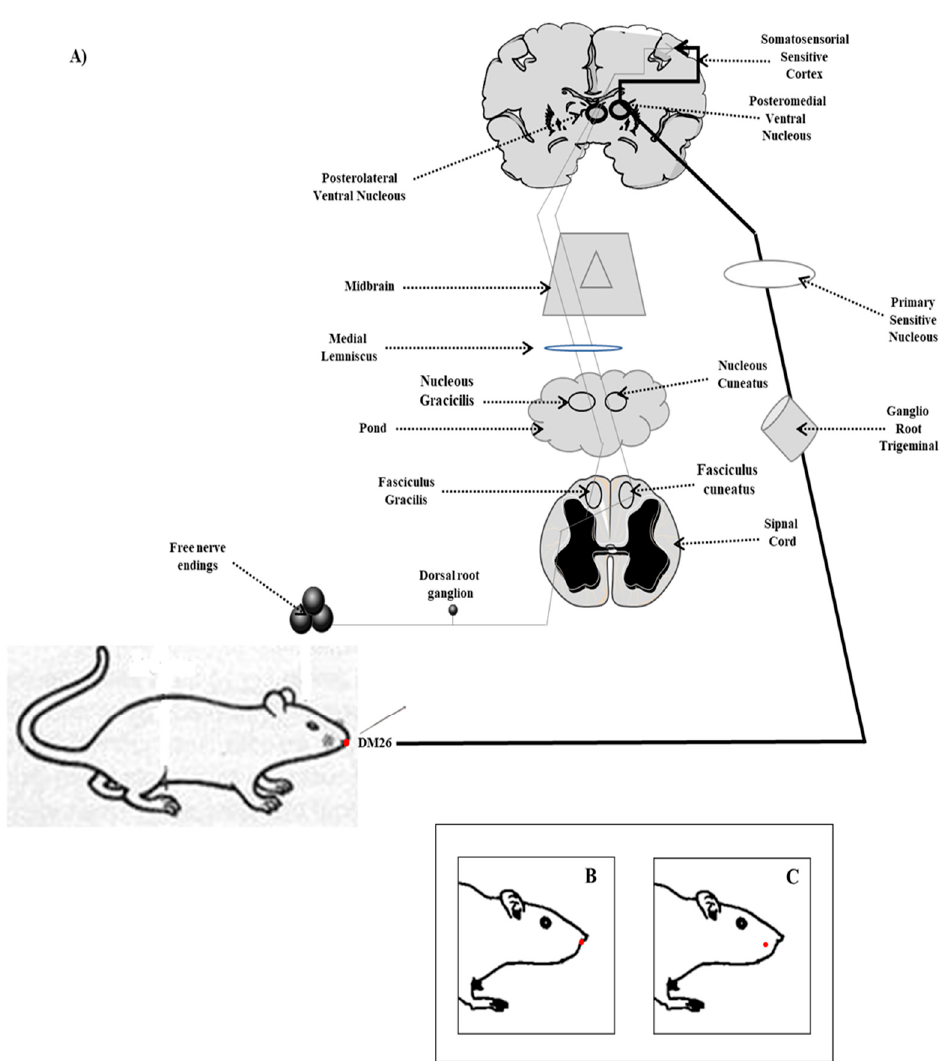
Figure 1. Stimulation points. ( A ) Shui Gou DM26 point showing the dorsal-lemniscus, medial lemniscus, and trigeminothalamic spinal pathways leading the acupuncture stimulus to the posteromedial ventral nucleus for its integration into the primary sensory cortex, ( B ) localization according to Bregma ( C ) non-point.